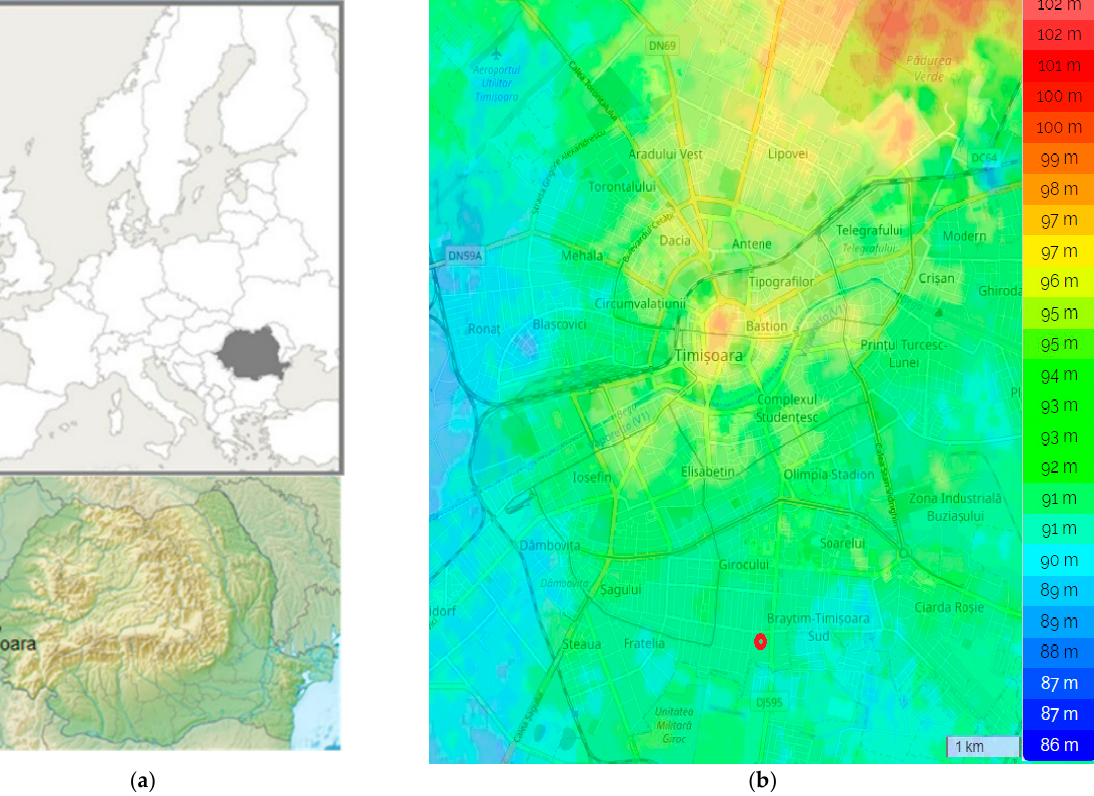
Figure 2. Location of the case study: ( a ) country context, ( b ) Timi ș oara’s urban layout on topographic map and location of the Experimental Module. Reprinted from [17].